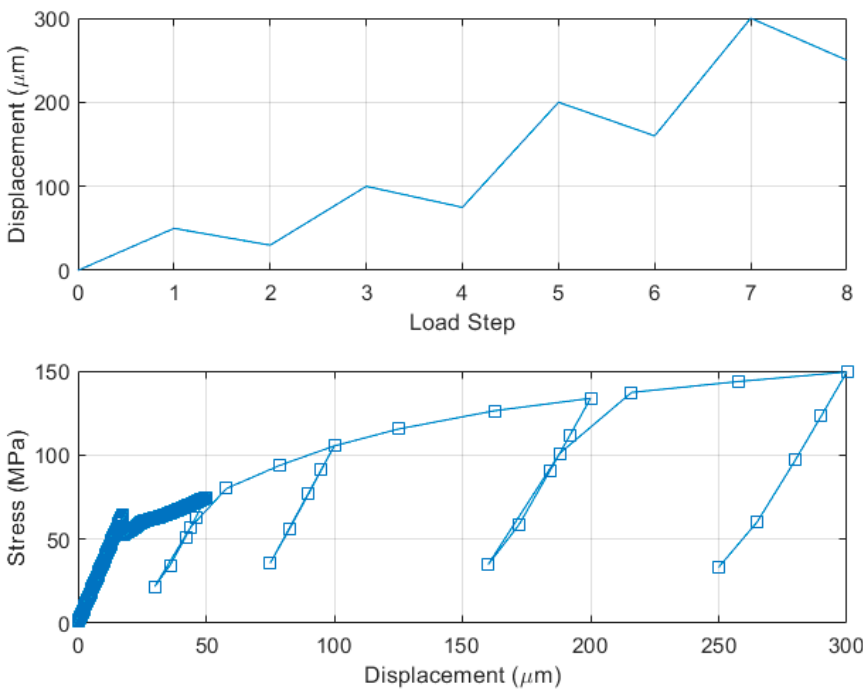
Figure 13. Tensile test of the FPCB model with cyclic loading; loading condition ( top ) stress-displacement curve ( bottom ).